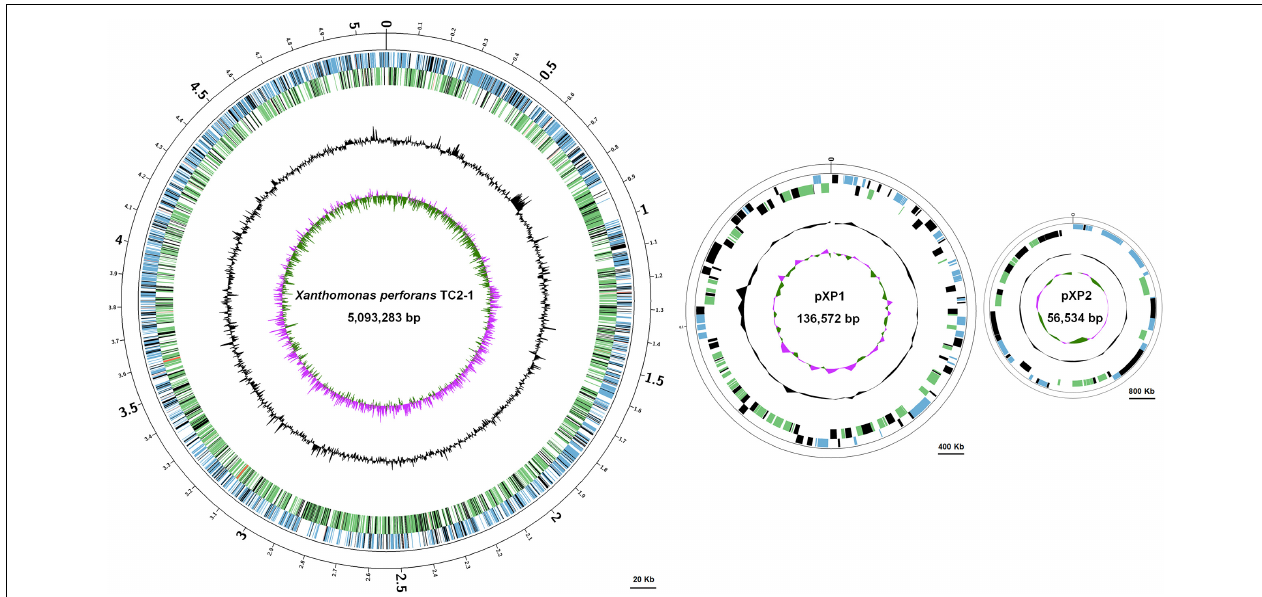
FIGURE 5 | Circular map of the chromosome and two plasmids pXP1 and pXP2 of Xanthomonas perforans s train TC2-1. The circles from outside to inside represent feature of the positive strand, CDS (blue), rRNA (red), pseudogene (black); feature of the negative strand, CDS (green), rRNA (red), pseudogene (black); GC content; and GC-skew. Bars were indicated under each of the circular maps.